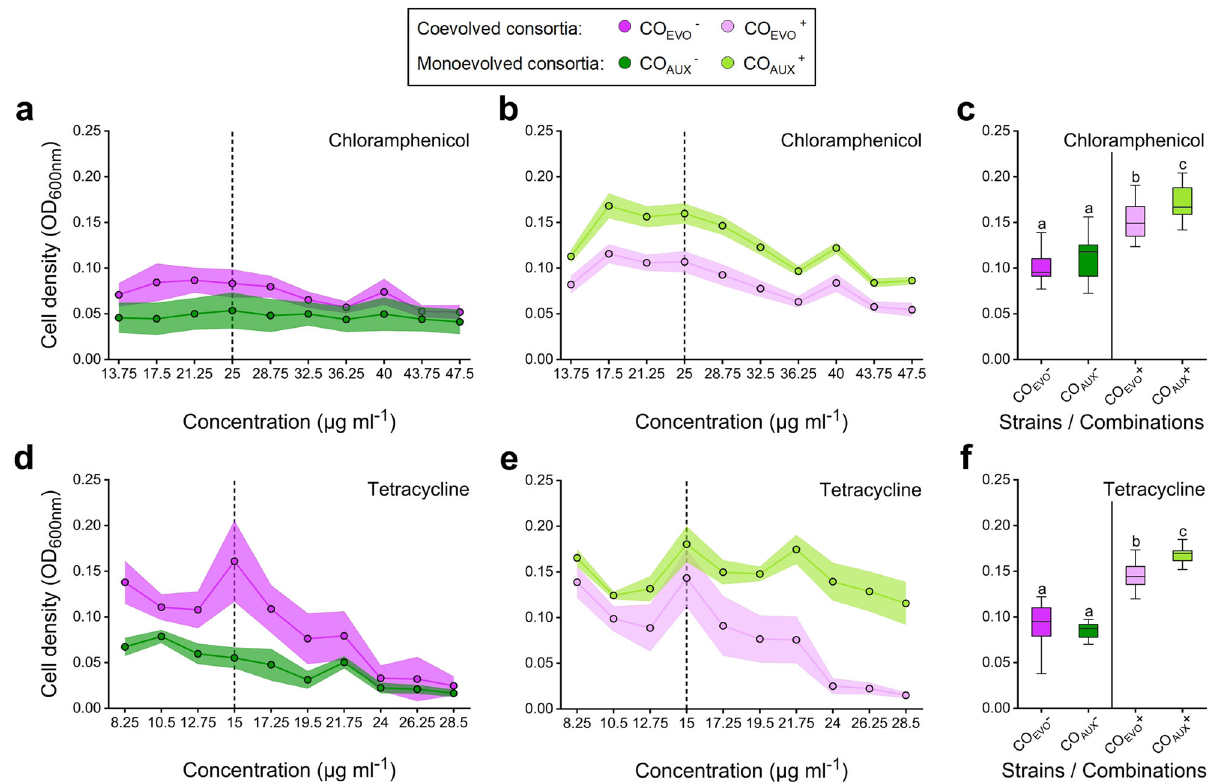
Fig. 4 Both coevolutionary history and mutualistic dependence affect the ability of cooperative mutualists to adapt to environmental change. Shown is the growth of coevolved auxotrophs (CO EVO , purple circles and boxes) and cocultured monoevolved auxotrophs (CO AUX , green circles and boxes) determined as population density (OD 600nm ) with ( + ) or without ( − ) supplementation of tryptophan and tyrosine (100 µ M each). The antibiotic, to which the respective consortia have been exposed in the evolution experiment, is indicated in each panel. Cultures were grown with a , b chloramphenicol, d , e tetracycline or c , f not treated with any antibiotic. The dashed lines mark the typical working concentration of the respective antibiotic. Data is shown as ( a , b , d , e ) mean (±95% con fi dence interval) or as c , f box plots with median values (horizontal line in boxes) and the upper and lower quartiles (i.e. 25 – 75% of data, boxes). Whiskers indicate the 1.5x interquartile range. Different letters above boxes indicate signi fi cant differences between groups (two- sided Mann – Whitney U -test followed by Benjamini – Hochberg correction: P < 0.05, n = 16). For exact P -values, see Supplementary Table 6. Source data are provided as a Source Data fi